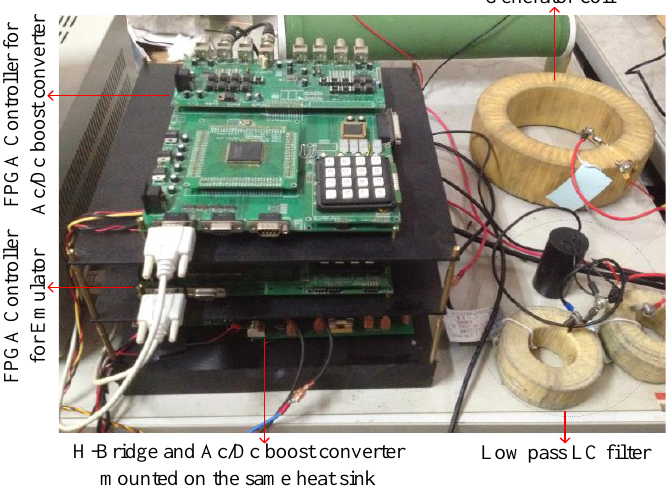
Figure 11. Experimental setup of wave energy emulator and AC/DC power conversion.